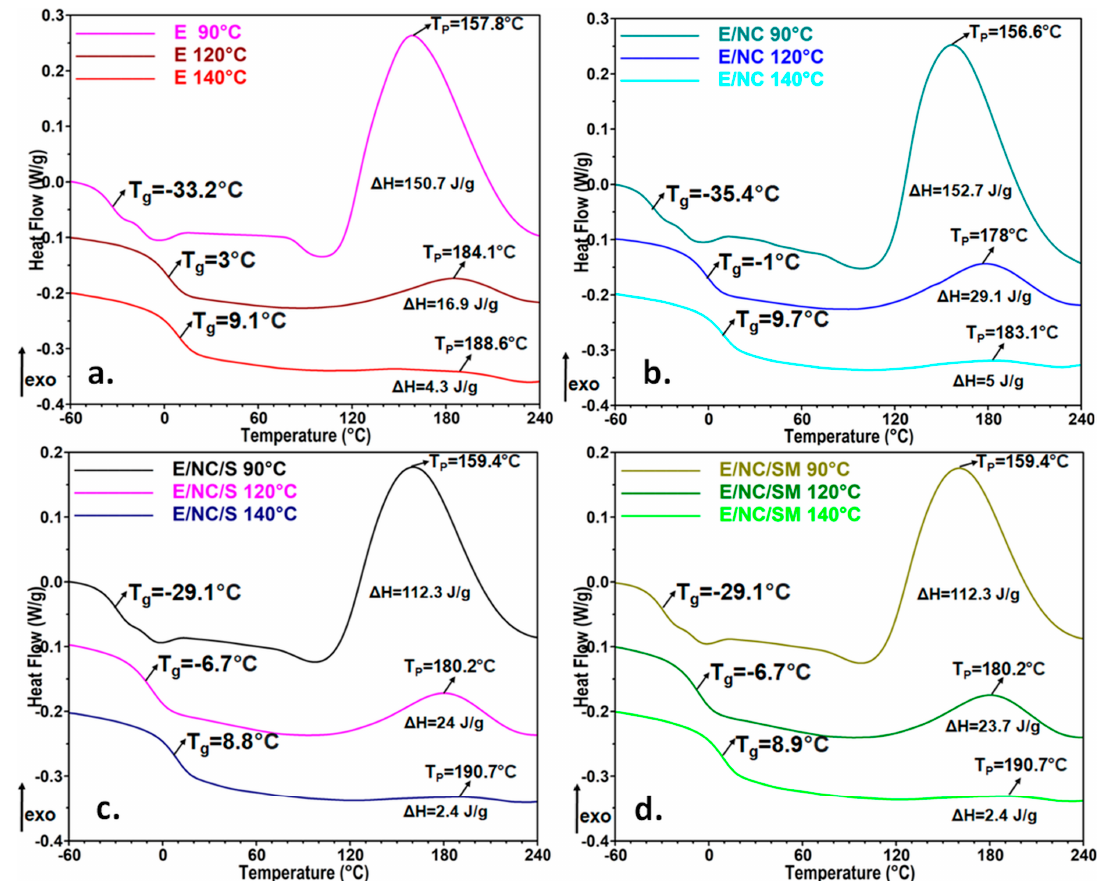
Figure 3. DSC thermograms of the curing process of the neat epoxy system ( a ) and nanocomposites containing ungrafted ( b ) and grafted NCs ( c , d ).